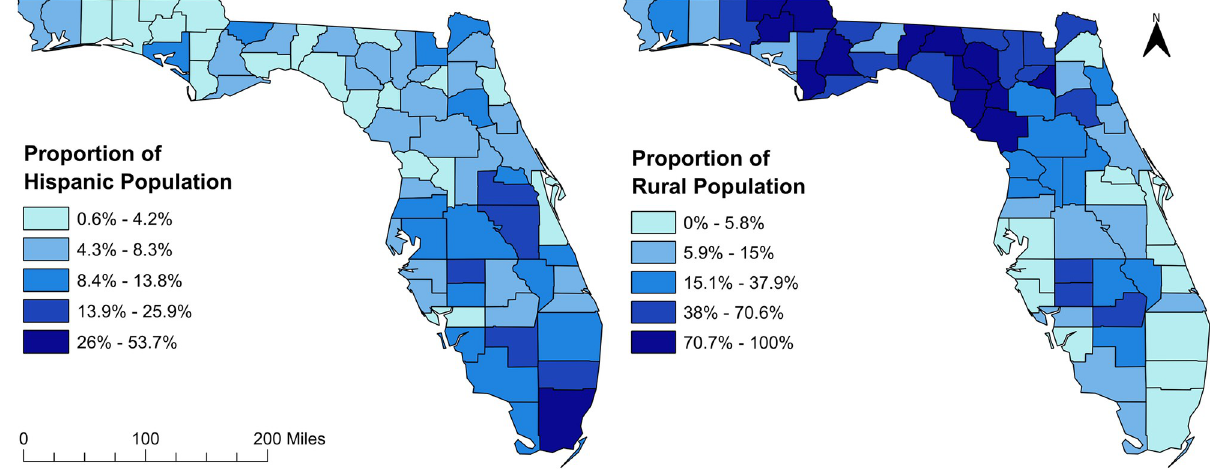
Fig 5. Distribution of significant predictors of diabetes self-management education program participation rates in Florida, 2010. Figure was created using the Free and Open Source Geographic Information System (GIS) software, QGIS. The basemaps used to create the maps were downloaded from the US Census Bureau Website: https://www.census.gov/geographies/mapping-files/time-series/geo/tiger-line-file.2010.html. The data on Hispanic population distribution can be downloaded from Florida Department of Health Website: http://www.floridahealth.gov/statistics-and- data/survey-data/behavioral-risk-factor-surveillance-system/index.html. The rural population data were downloaded from County Health Rankings Website available at: https://www.countyhealthrankings.org/app/florida/2021/measure/factors/58/data.